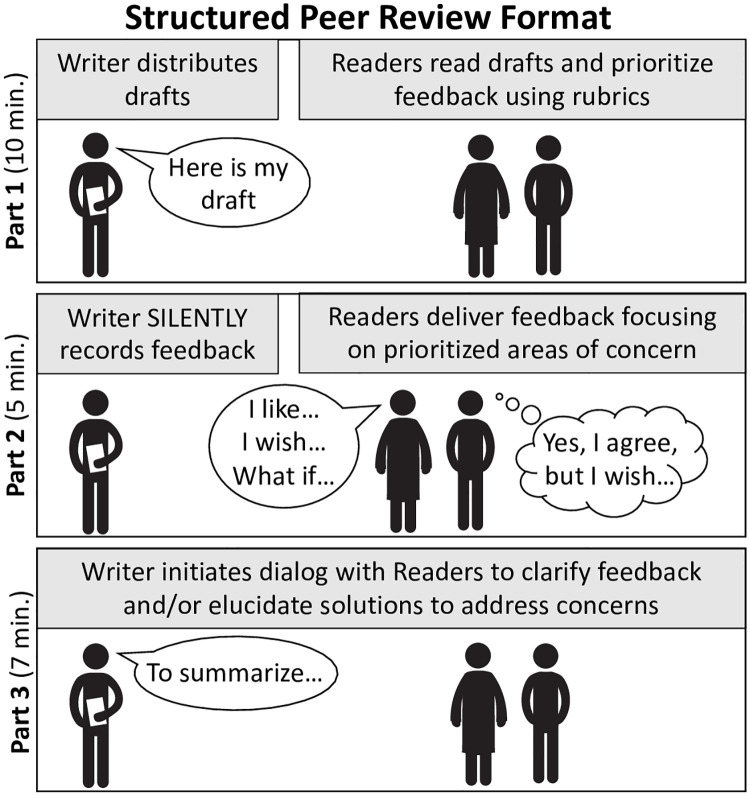
During the weekly meetings, documents were peer reviewed using a structured format.Peers participated in each peer-review role (Writer or Reader) each week, thus receiving prioritized feedback from peer reviewers. This structured format ensured fast, organized, and effective feedback.